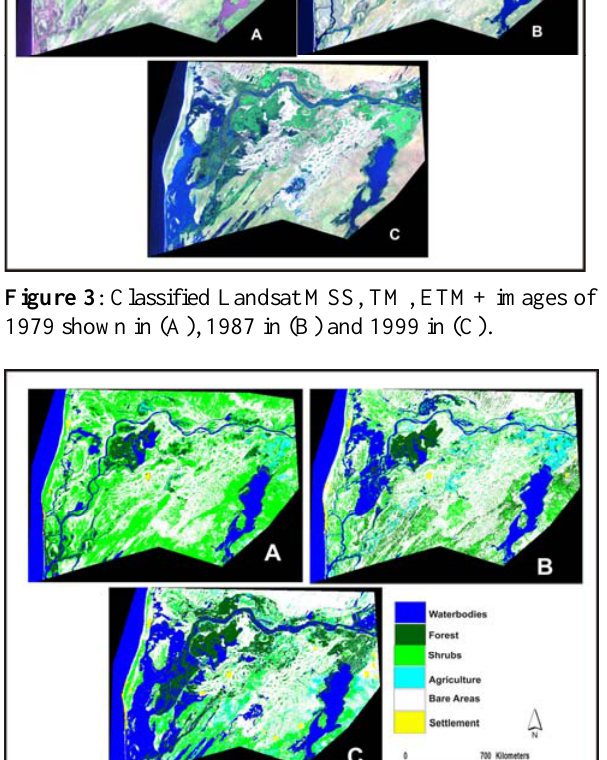
Table 4: Results of the classified Images 1979, 1987 and 1999